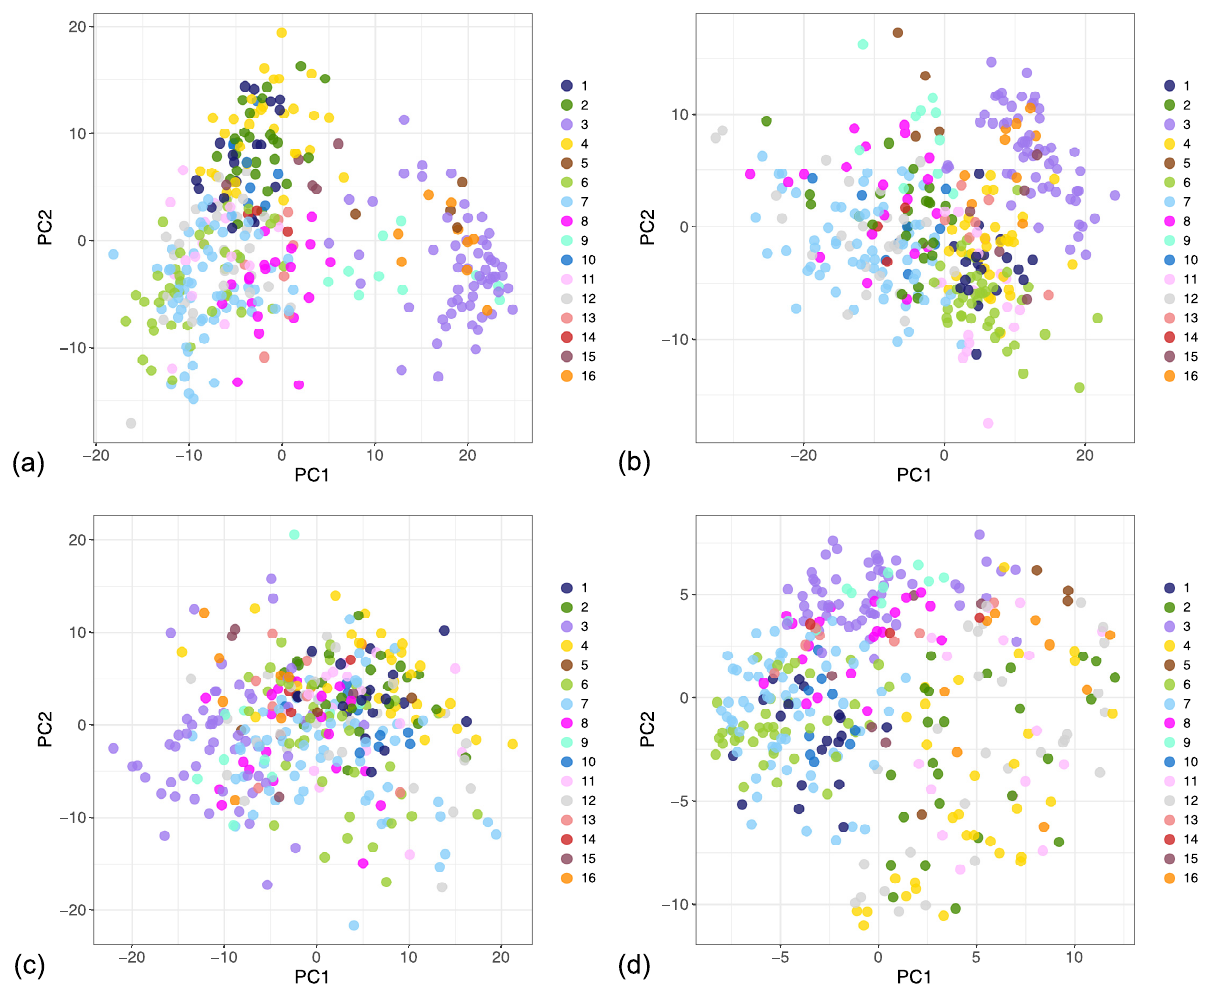
Fig 7. PCA projection of the global clusters in individual contexts in the breast cancer dataset from TCGA, from the model with 3 context-specific clusters and up to 18 global clusters. The colours correspond to the coloursused in the survival curves in Fig 6. (a) Gene expressioncontext. (b) DNA methylationcontext. (c) miRNA expressioncontext. (d) RPPA